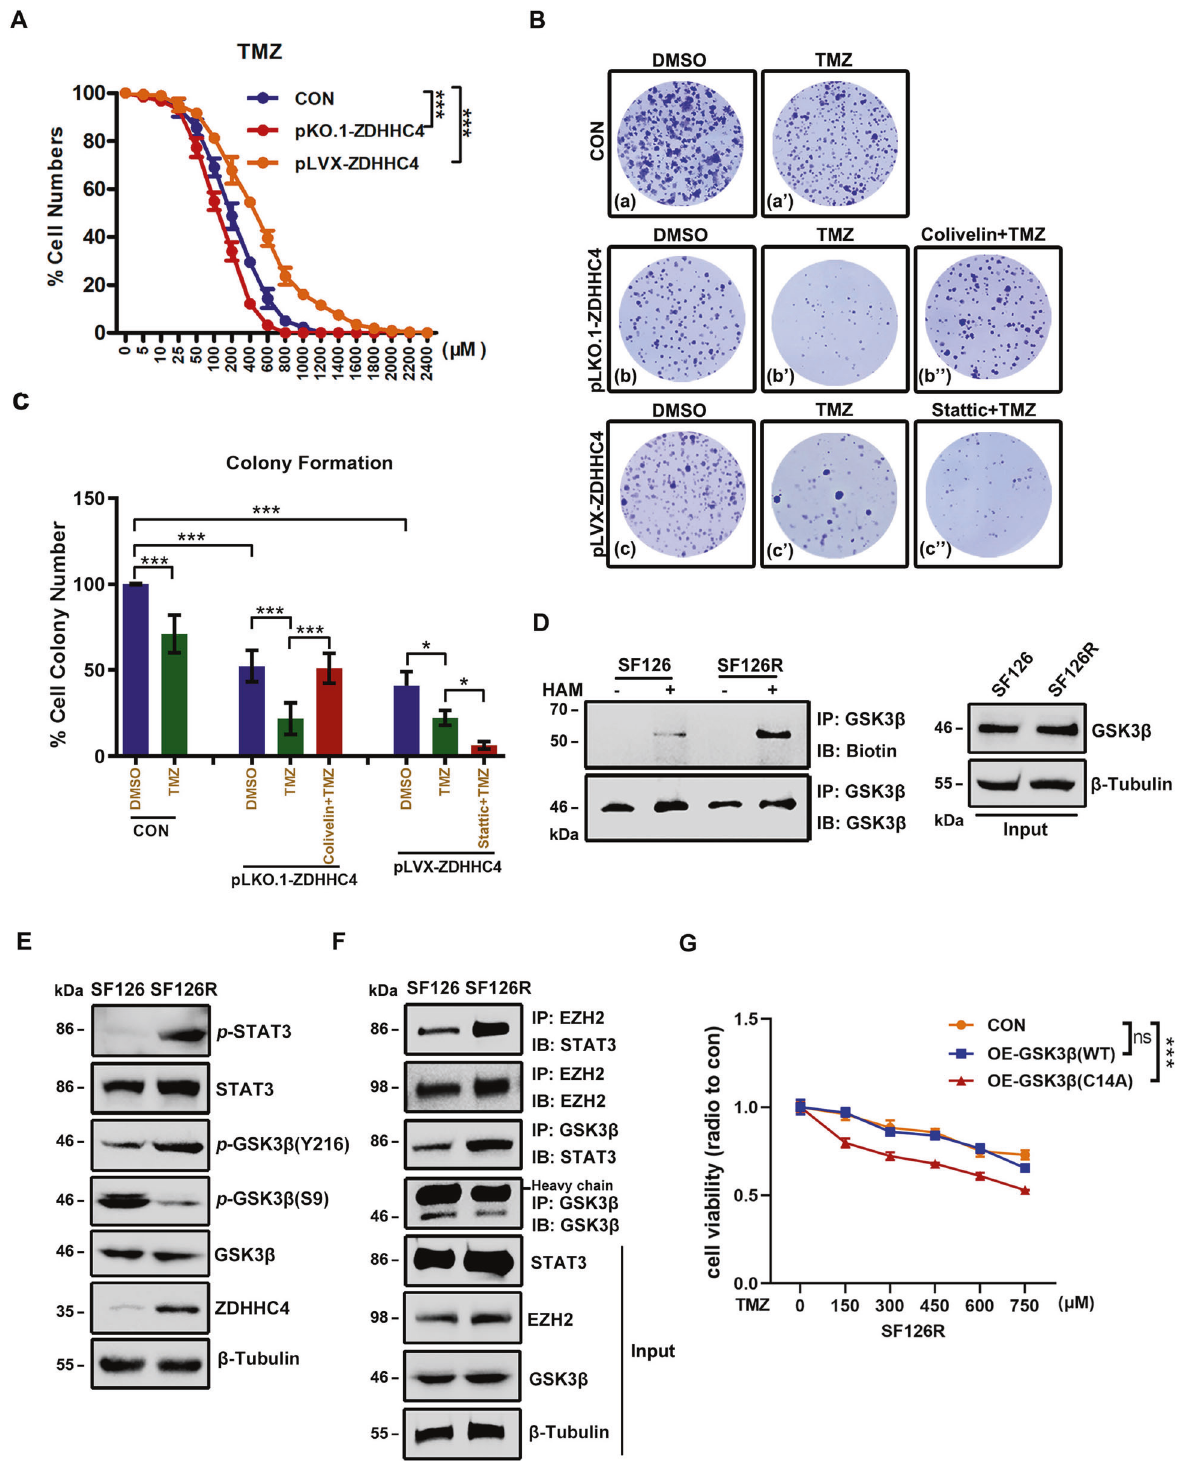
Fig. 3 GSK3 β palmitoylation regulates GBM TMZ-resistance. A Growth curve describing the effect of ZDHHC4 expression on TMZ inhibition in GBM cells. SF126 cells with overexpression or knockout of ZDHHC4 were treated with different concentrations of TMZ. B Representative image of colony formation in the SF126 cell lines 14 days after different treatments. For the control group, DMSO and TMZ were used. For the pLKO.1-ZDHHC4 group, DMSO, TMZ, and TMZ + Colivelin were used. For the pLVX-ZDHHC4 group, DMSO, TMZ, and TMZ + Stattic were used. Colonies were stained using crystal violet. C The number of clones stained by crystal violet in each dish in Figure B is calculated. Con-DMSO group was set at 100%. D ABE analysis of GSK3 β palmitoylation in SF126 and SF126R cells. E Western blot analysis of GSK3 β and STAT3 phosphorylation in SF126 and SF126R cells. F Immunoprecipitation analysis of the STAT3 binding capacity of GSK3 β and EZH2 in SF126 and SF126R cells. G CCK-8 assay was used to detect the effect of GSK3 β (C14A) mutant on TMZ killing SF126R cells. Data are shown as means ± SD ( n = 3). P -values were determined by two-tailed Student ’ s t -test. * P < 0.05; ** P < 0.01; *** P < 0.001.